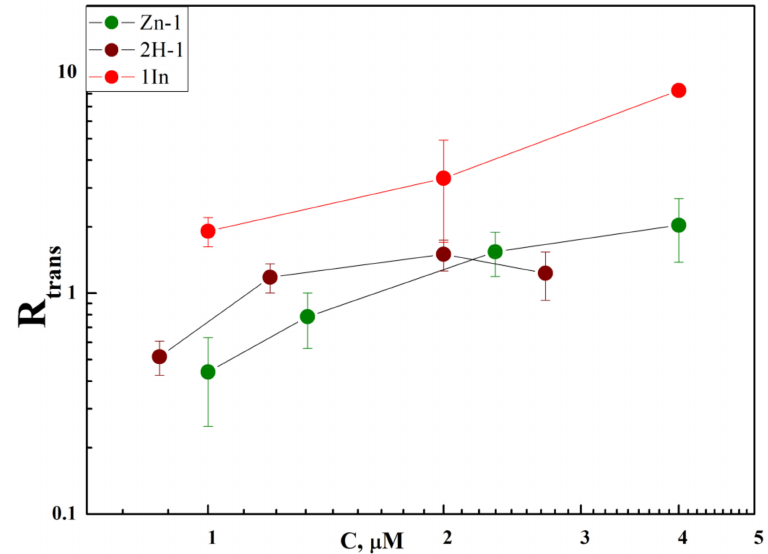
Figure 5. The dependence of the rate of oxidation of di-4-ANEPPS on the concentration of porphyrins in the water solution containing 20 mM KCl, 2 mM HEPES, pH 7.0. Data for In(III) complex of β -imidazolium-substituted porphyrin (1In, red) were taken from [8] for the